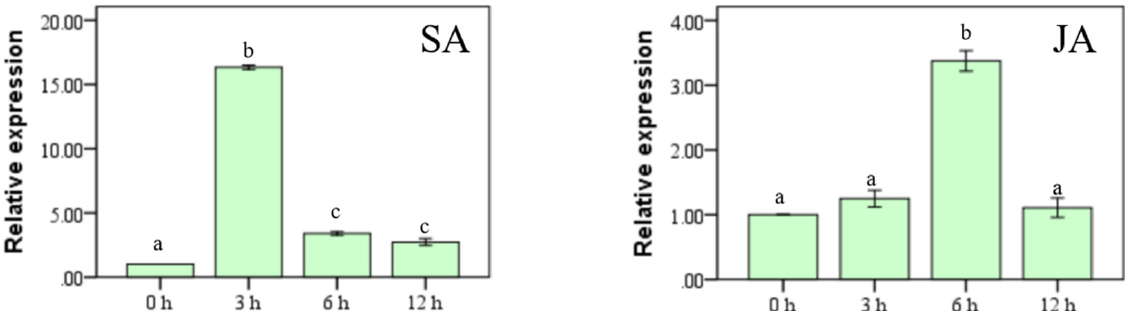
Figure 3. Expression patterns of SlMYBS2 in response to defense signaling hormones. Tomato plants were treated by foliar spraying of 400 µ M SA and 200 µ M JA. Gene expression was analyzed by qRT-PCR, and the relative expression levels were calculated by comparison with the corresponding values at 0 h (as a control) after treatment. Relative expression is shown as the fold change in the actin transcript values. The data are presented as the means ± SDs from three independent experiments, and the different lowercase letters indicating significant differences at the 0.05 level.